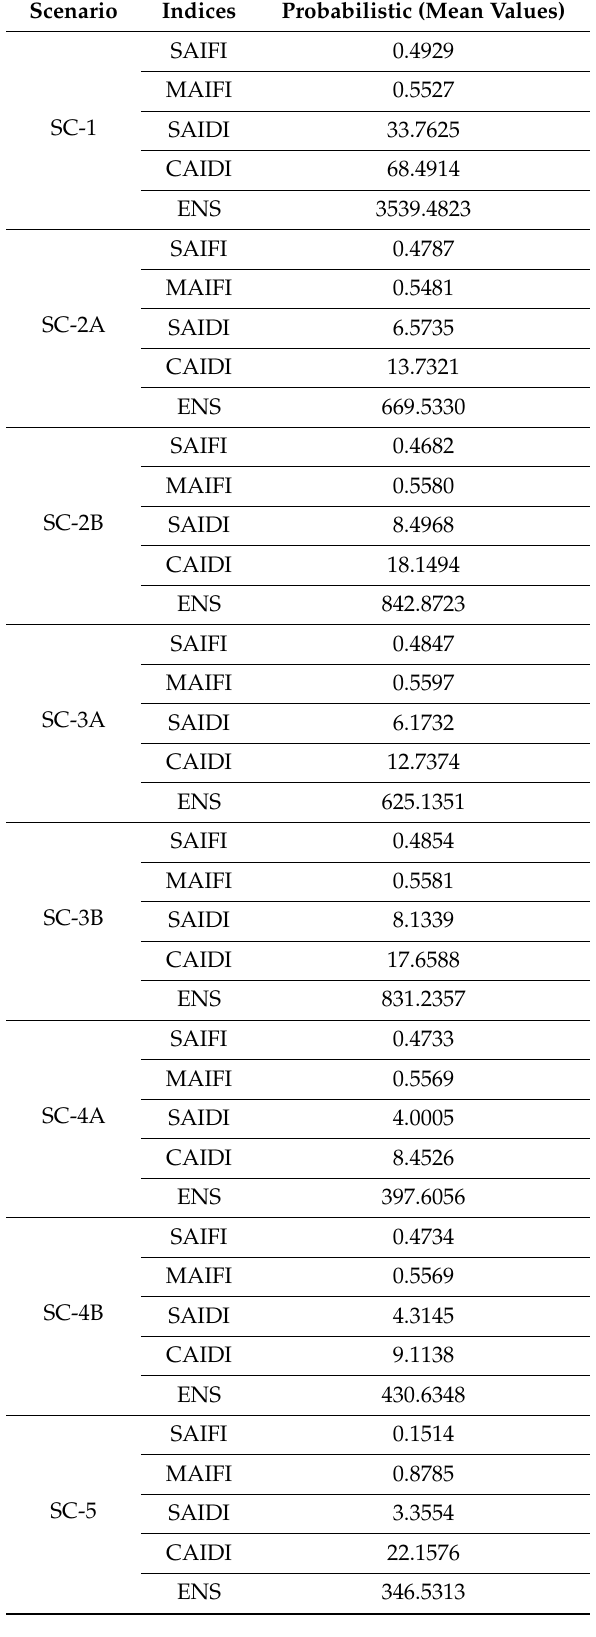
Table 6. Scenario SC-1 to